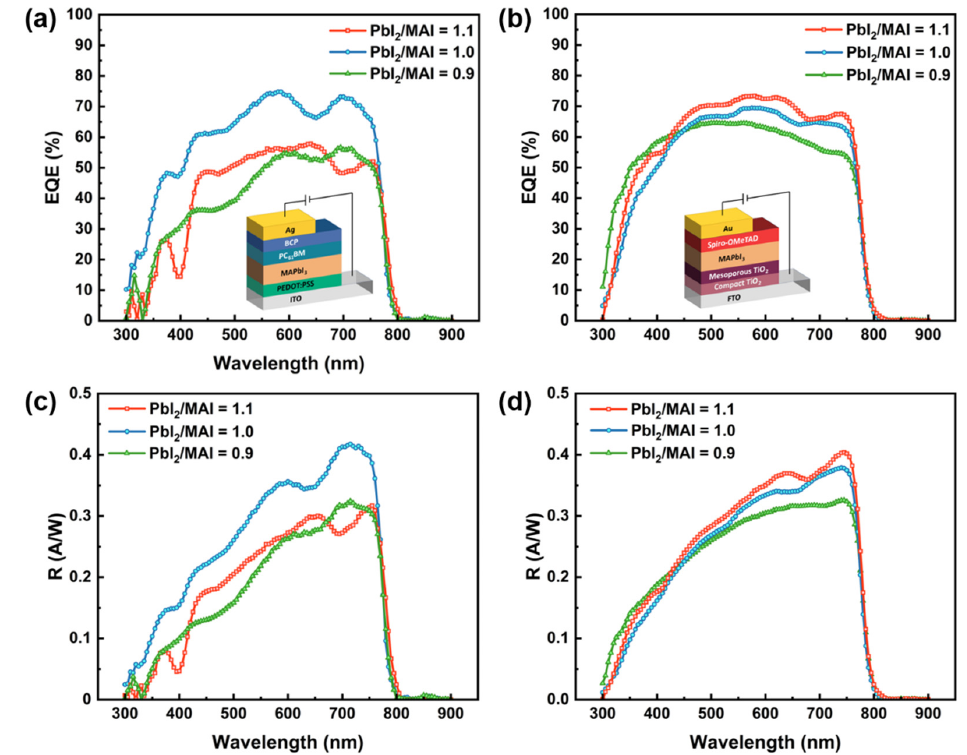
Figure 7. Variation in EQE and responsivity with wavelength under different precursor ratios an- nealed at 80 °C for 10 min, where ( a , c ) are for inverted structure photodiode and ( b , d ) are for regular structure photodiode.